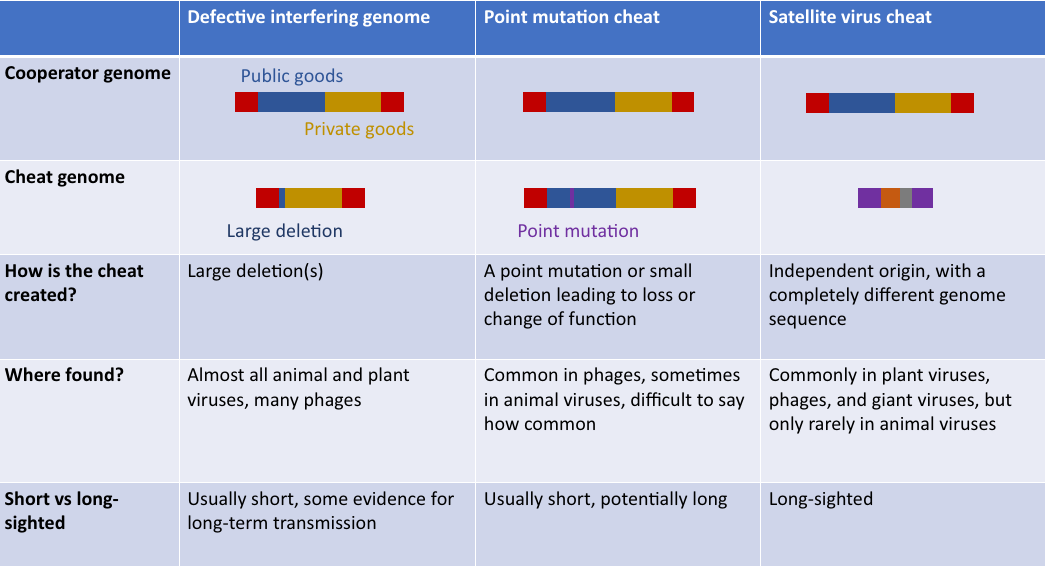
Fig. 5 Viral cheat origins. A number of different molecular mechanisms can give rise to viral cheats. The evolutionary perspective highlights the functional similarities between these mechanistically different cheats. Here, we show three different types of cheat, which arise in different ways: large deletion; point mutation; and independent